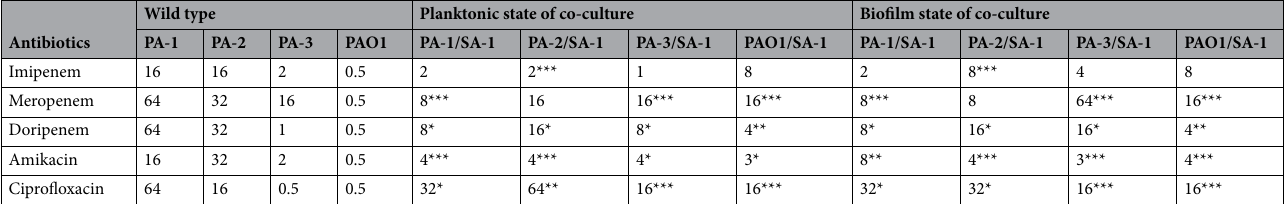
Table 1. Antibiotic susceptibility of recovered P. aeruginosa strains. *P-value < 0.01; **P-value < 0.001; ***P-value <